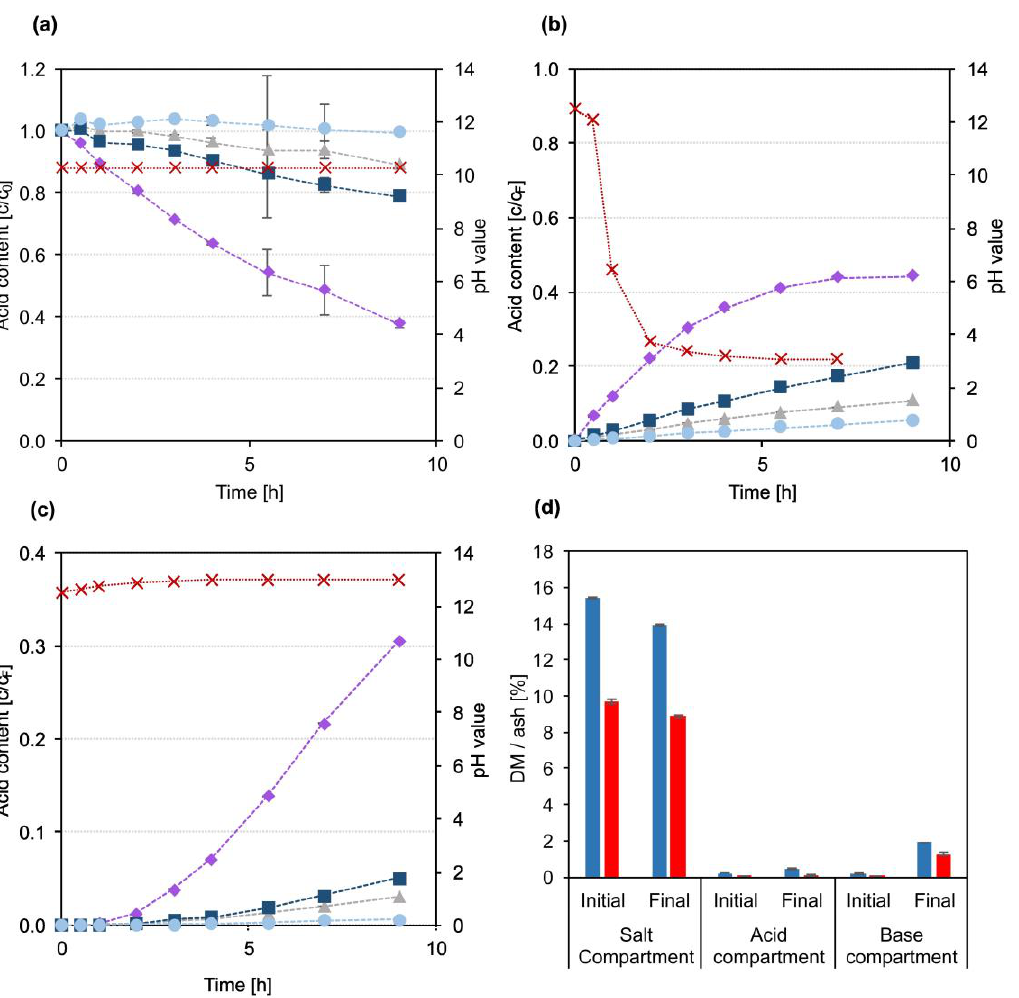
Figure 3. Development of carboxylic acid concentrations and pH value over the course of the EDBM experiment with BL permeate. ( a ) Salt compartment; ( b ) acid compartment; ( c ) base compartment. For ( a – c ): ■ glycolic acid, ● lactic acid, ♦ formic acid, ▲ acetic acid, x pH value. ( d ) DM ( ■ ) and ash ( ■ ) content measured in the initial and final samples from the three compartments.